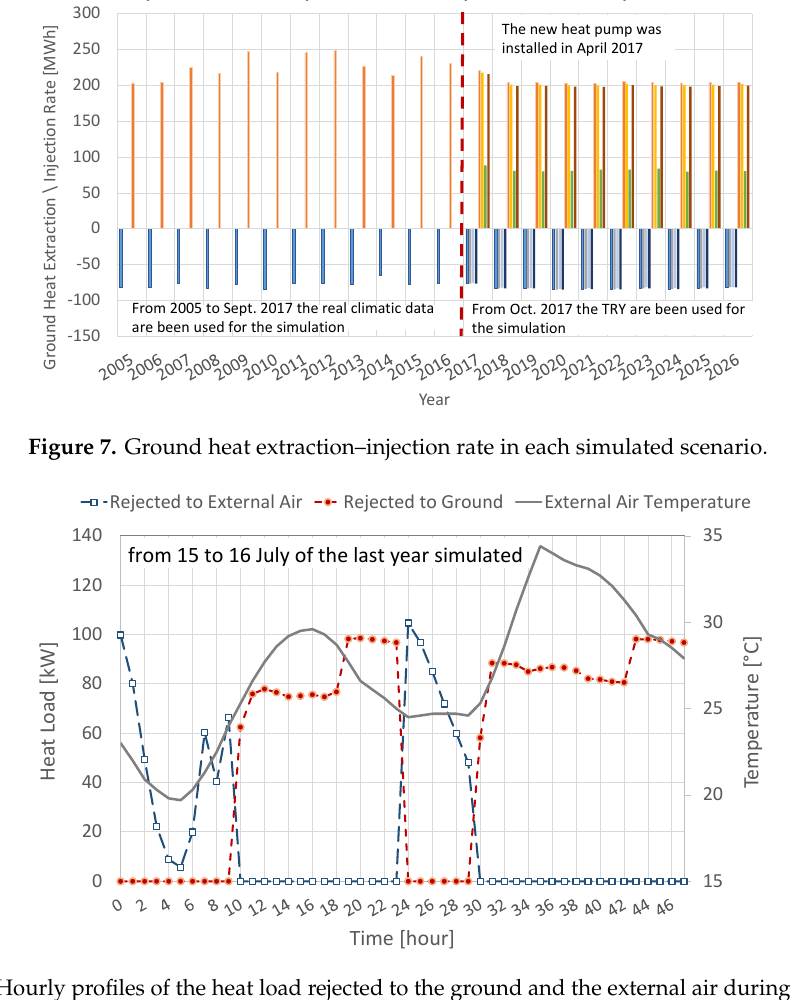
Figure 8. Hourly profiles of the heat load rejected to the ground and the external air during the 15 and 16 July of the last simulated year in Scenario 3 .